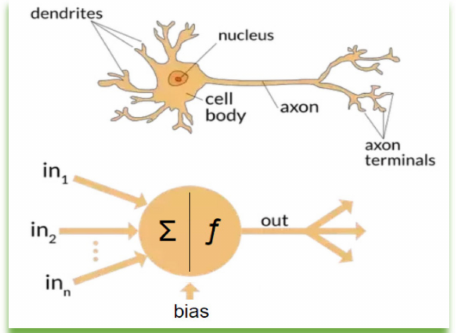
Figure A2. Human Brain and its Simulation Through ANN Ref.